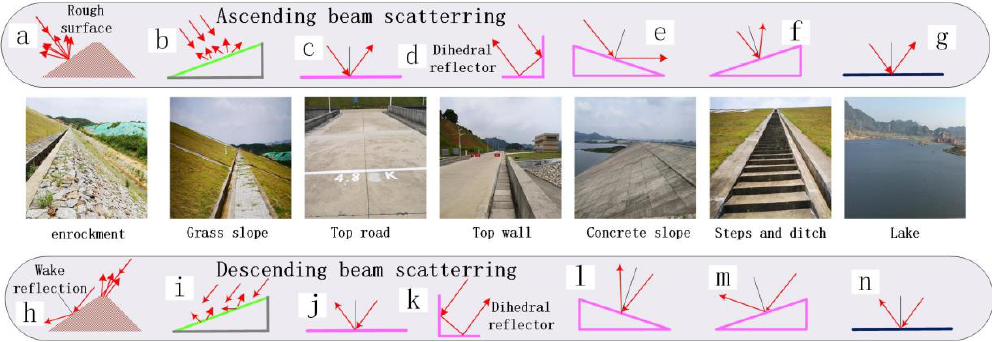
Figure 8. The dam surface material scattering geometry on the ascending and descending images.